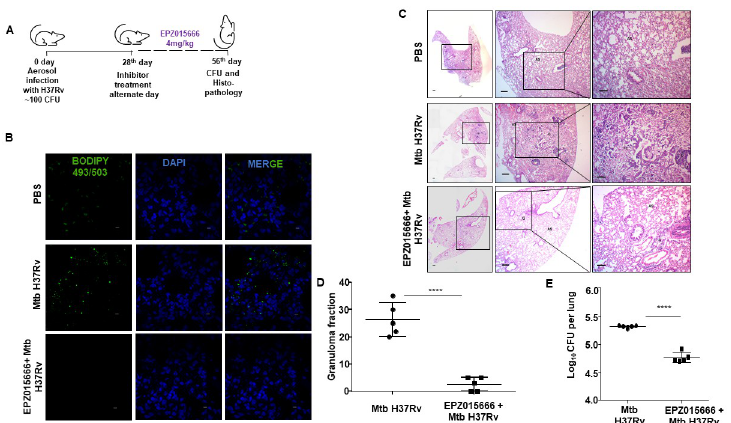
Fig 6. Inhibition of PRMT5 alleviates TB pathology. (A) Schematic representing the therapeutic regimen followed in a mouse model of Mtb infection. (B-E) BALB/c mice were infected with Mtb H37Rv and treated with PRMT5 inhibitor EPZ015666 (4mg/kg) as indicated in (A). (Number of mice per group = 5) (B) Lung cryosections were assessed for lipid accumulation by confocal microscopy (BODIPY493/503) (number of mice from which lung sections were assessed = 3 per group). (C, D) TB pathology (granulomatous lesions) in the lungs was analyzed by H and E staining; (C) representative images and (D) respective quantification (number of mice per group = 5). (E) Mycobacterial burden in the lungs of infected and PRMT5 inhibitor treated mice was enumerated by plating lung homogenates on 7H11 plates (number of mice per group = 5). Specific regions of the H and E-stained sections were zoomed by the pathologist for evaluation of granuloma fraction. Accordingly, the portions that have been zoomed are demarcated in the images; Magnification, 4X (left panel); 40X (middle panel); 100X (right panel); Scale bar for H and E images, 200 μ m. Scale bar of immunofluorescence, 5 μ m. G, granulomatous lesion; AS, alveolar space, FC, foam cell; CFU, colony forming units. ���� , p < 0.0001 (Student’s t-test; GraphPad Prism